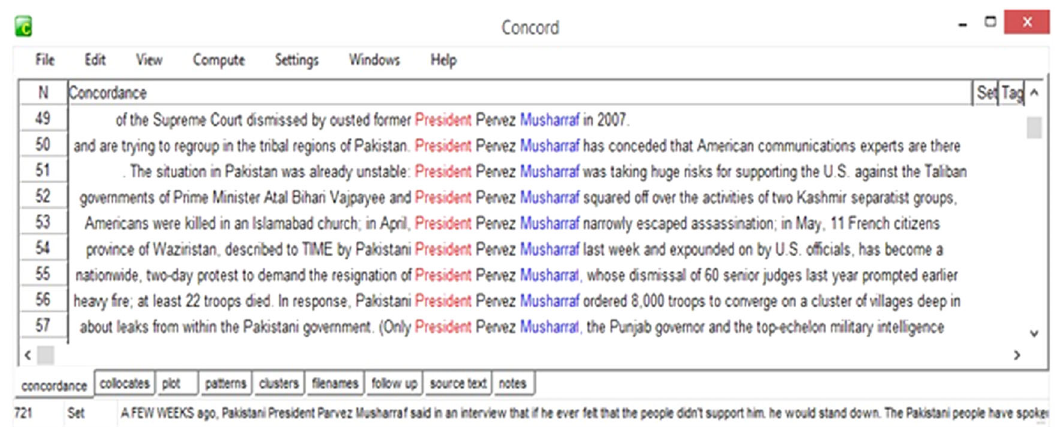
Fig. 5 Concordance extract. Concordance extract Government-Musharraf* .